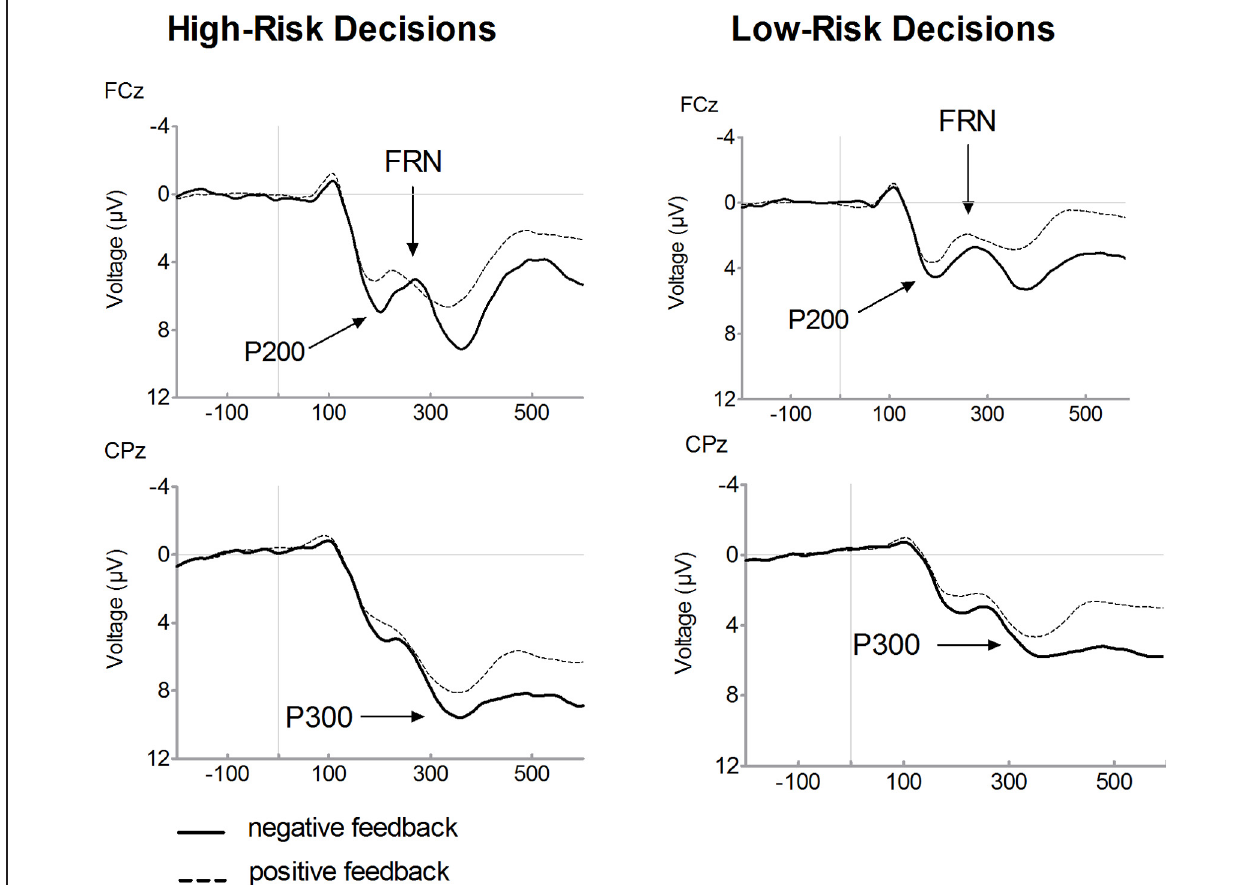
determined as the most positive peak between 100 and 300ms. The FRN was computed as the difference between the most negative peak following feedback onset in a 200 to 400ms time window and the preceding positive peak between 100 and 300ms. The P300 was defined as the mean amplitude in the time range between 300 and 400ms after feedback